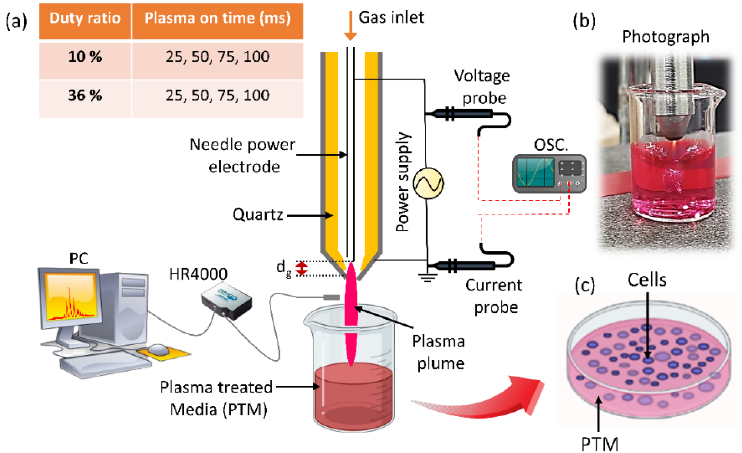
Figure 1. ( a ) The schematic of soft plasma jet and experimental setup. Two fixed duty ratios of 10% and 36% were used with plasma on ‐ time (25, 50, 75, and 100 ms) to prepare PTM and its applications to the U87 ‐ MG cell line. The distance, d g , was used to represent the distance between the grounded electrode (nozzle) and the tip of the syringe power electrodes, which is set at 1 mm. ( b ) Photograph during treatment and ( c ) the application of PTM to the U87 ‐ MG cell line.